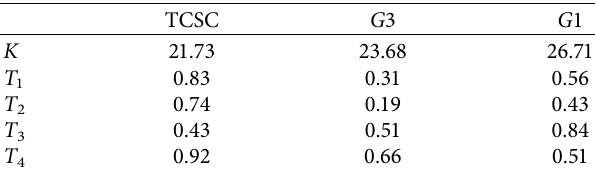
Table 5: Te optimal values of PSS2B and TCSC stabilizer